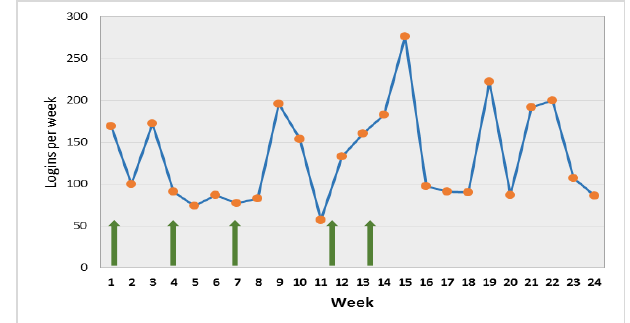
Table 1. Students’ creative and interaction